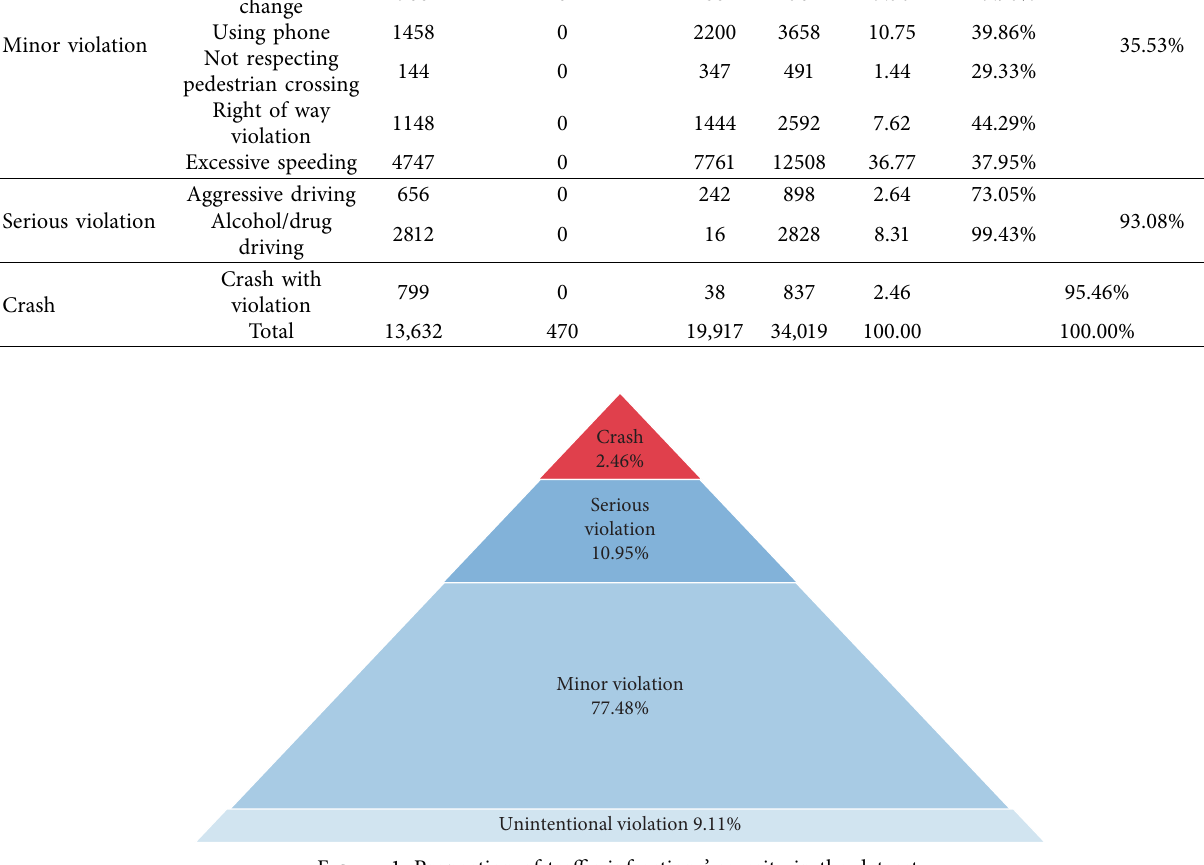
Figure 1: Proportion of traffic infractions’ severity in the